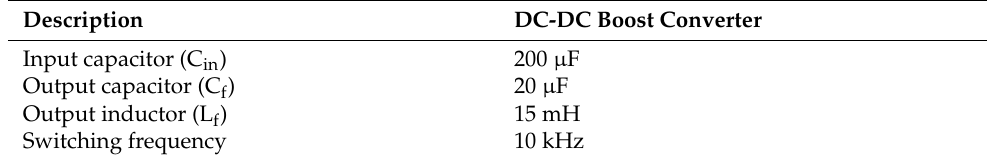
Table 2. System Table 2. System Specifications.